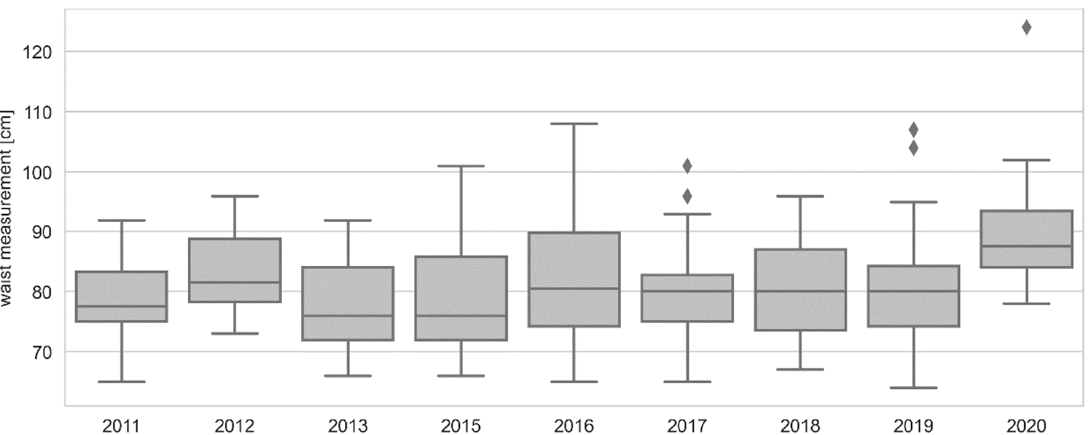
Figure 1. Graphical characteristics of the BMI of the surveyed women differing in the size of the